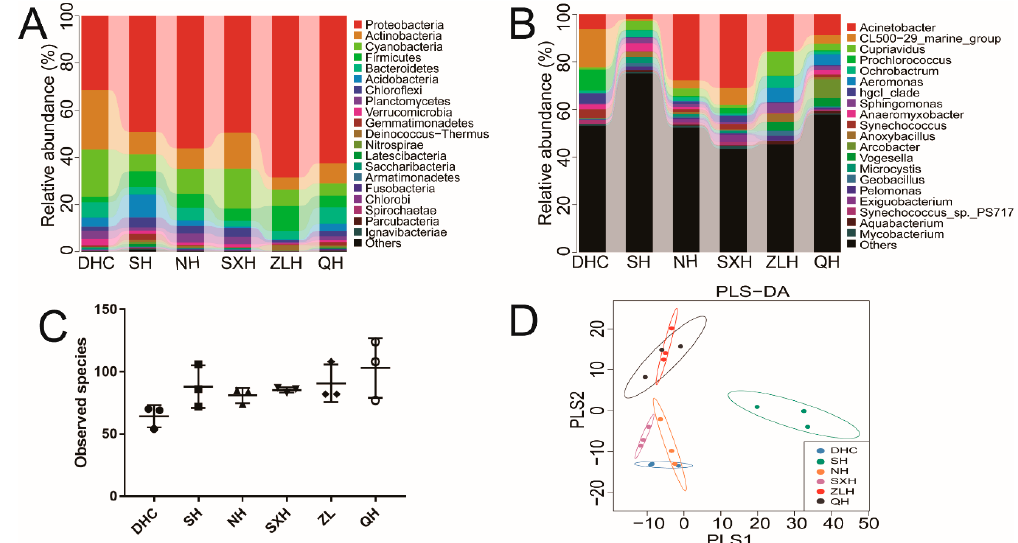
Figure 2. The diversity and richness of water bacteria among the Dahuchi (DHC), Shahu (SH), Nanhu (NH), Sixiahu (SXH), Zhelinhu (ZLH), and Qianhu (QH) groups. The relative abundance of the bacteria among these DHC, SH, NH, SXH, ZLH, and QH groups at the phylum level ( A ) and at the genus level ( B ). The x-axis represents the groups and the y-axis represents the relative abundance presented as a percentage. The amount of observed species in DHC, SH, NH, SXH, ZLH and QH groups ( C ). The x-axis shows the different groups and the y-axis shows the observed species. Validation of PLS-DA for species similarity and distribution among DHC, SH, NH, SXH, ZLH and QH groups ( D ).